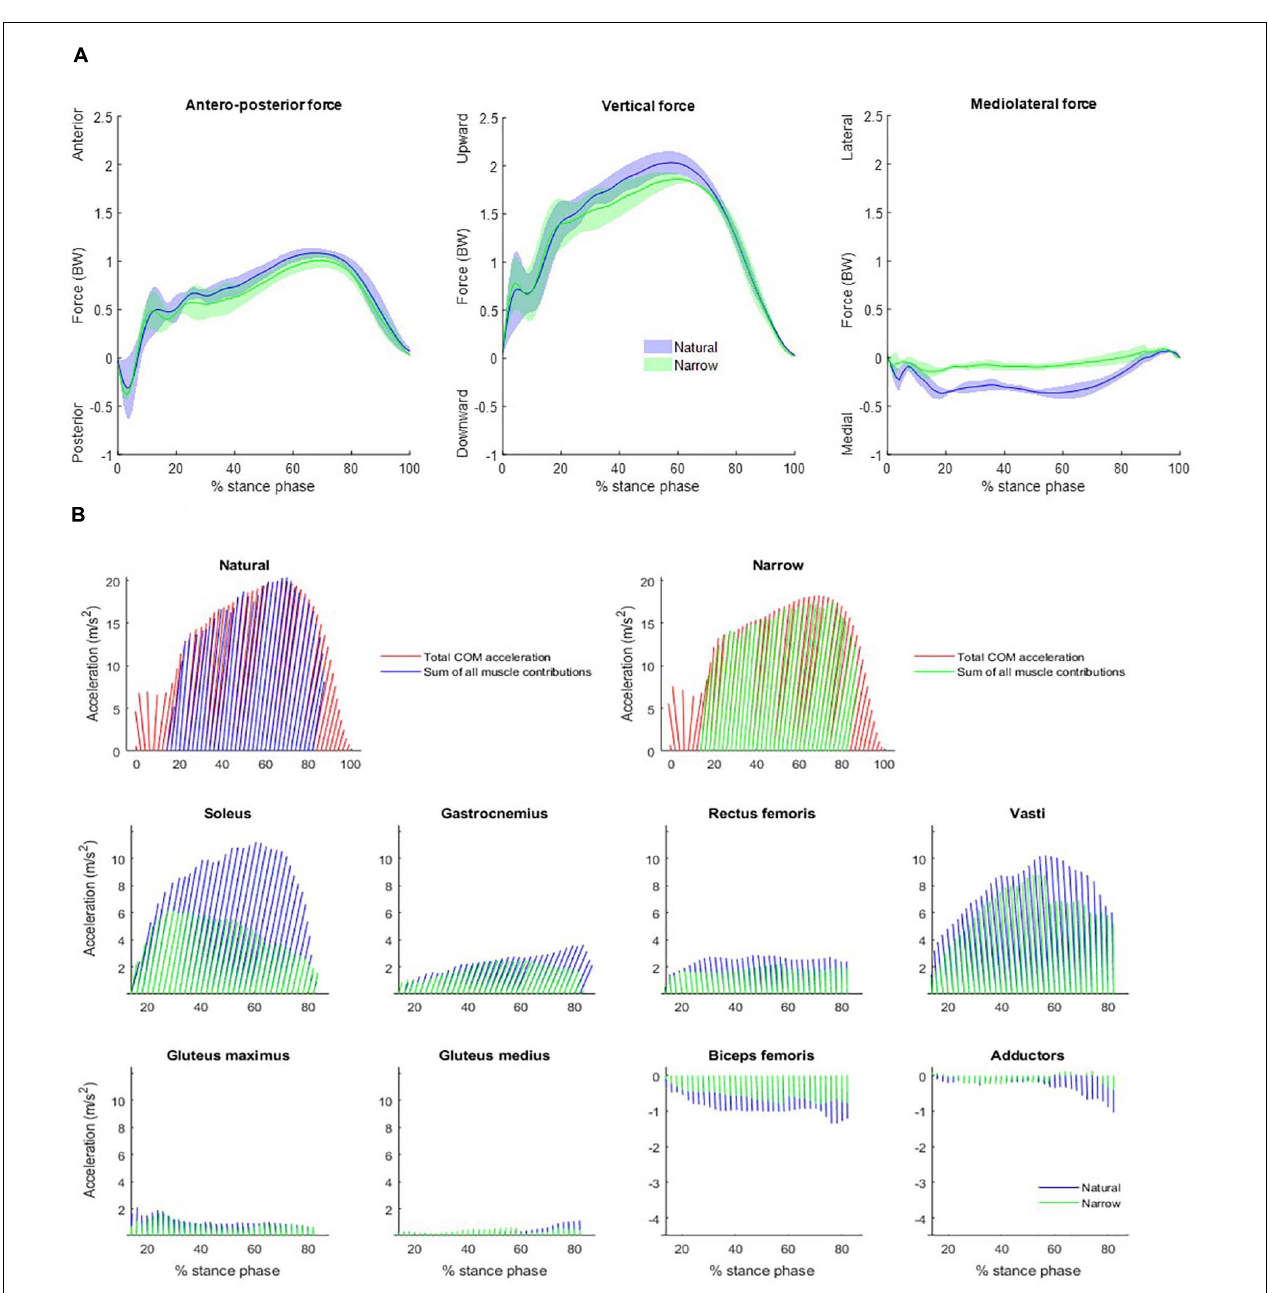
FIGURE 2 | (A) Measured GRF averaged across subjects over the stance phase. Each plot includes data of the natural (blue) and the narrow (green) trials. Solid lines represent the mean values and the colored areas represent the mean ± SD values. Forces are measured in body weight (BW). (B) Forward and vertical net accelerations and individual muscle contributions to body COM acceleration over the stance phase, averaged over all participants, shown as vectors at every 2% of the stance phase between 14 and 82% of the stance phase. Net accelerations (top) are the average of each participant’s measured GRF divided by his/her mass (red) and the sum of all the muscle contributions across the natural (blue) and the narrow (green) trials. Lower-limb muscles considered were soleus, gastrocnemius (medialis and lateralis combined), rectus femoris, vasti (vastus intermedius, lateralis, and medialis combined), gluteus maximus, gluteus medius, biceps femoris long head, and adductors (adductor brevis, longus and magnus, semitendinosus, semimembranosus and gracilis combined). Note that the scale of the y -axis varies among different